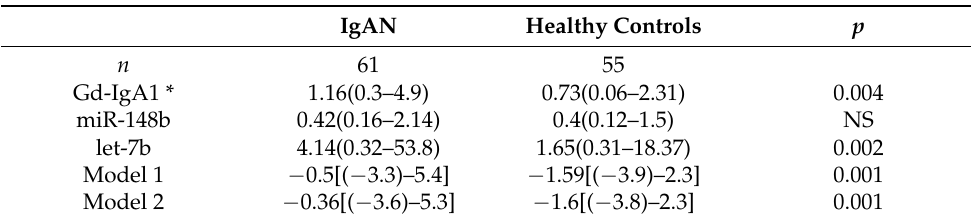
Table 2. Serum levels of Gd-IgA1, miR-148, and let-7b at time of renal biopsy, and calculated models in IgAN patients and healthy controls.